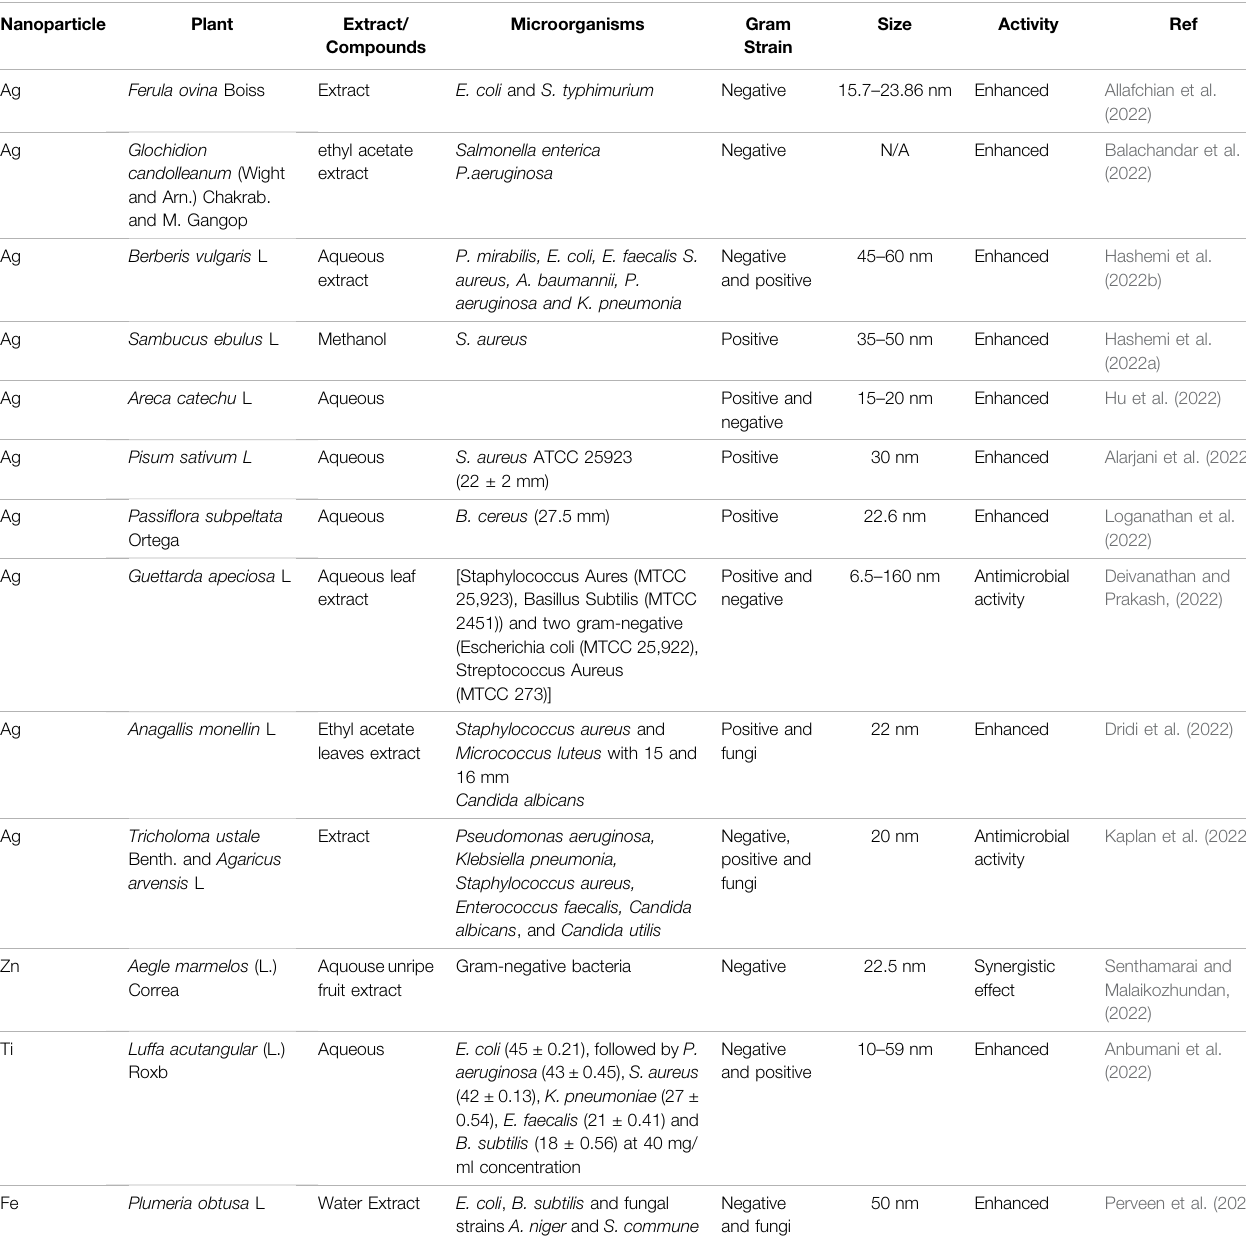
TABLE 3 | The synthesis of metallic nanoparticle in plant-based antimicrobial.